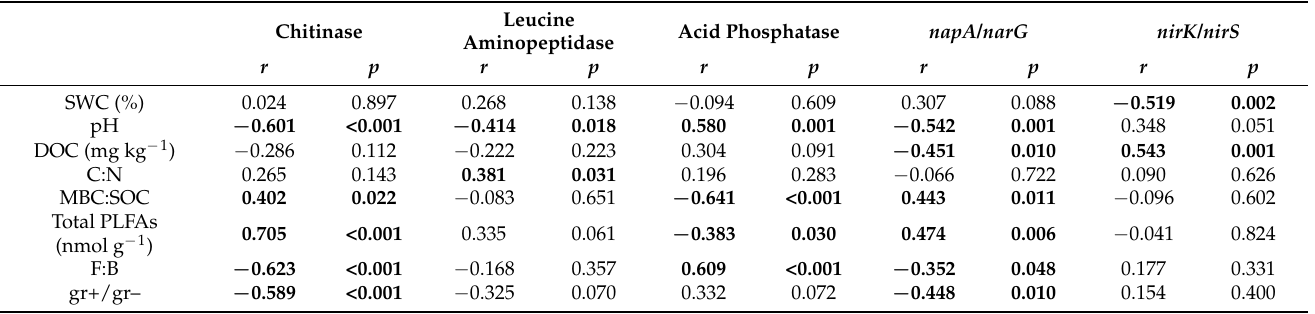
Table 2. Correlation matrix between soil enzyme activities and soil physicochemical (SWC, pH, DOC, C:N and MBC:SOC) and microbial parameters (Total PLFAs, F:B and gr+:gr − ratios). Significant correlations in bold print.